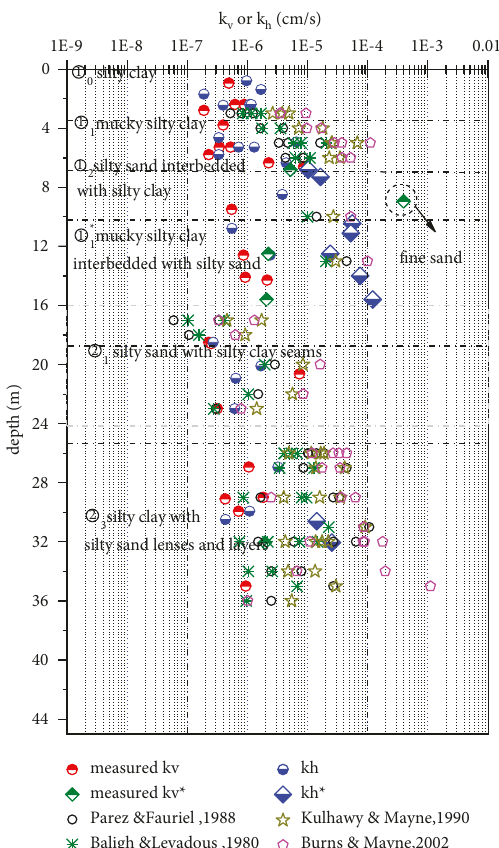
Figure 7: Comparison of vertical or horizontal k values obtained from laboratory tests to k (note: ∗ samples with silty sand